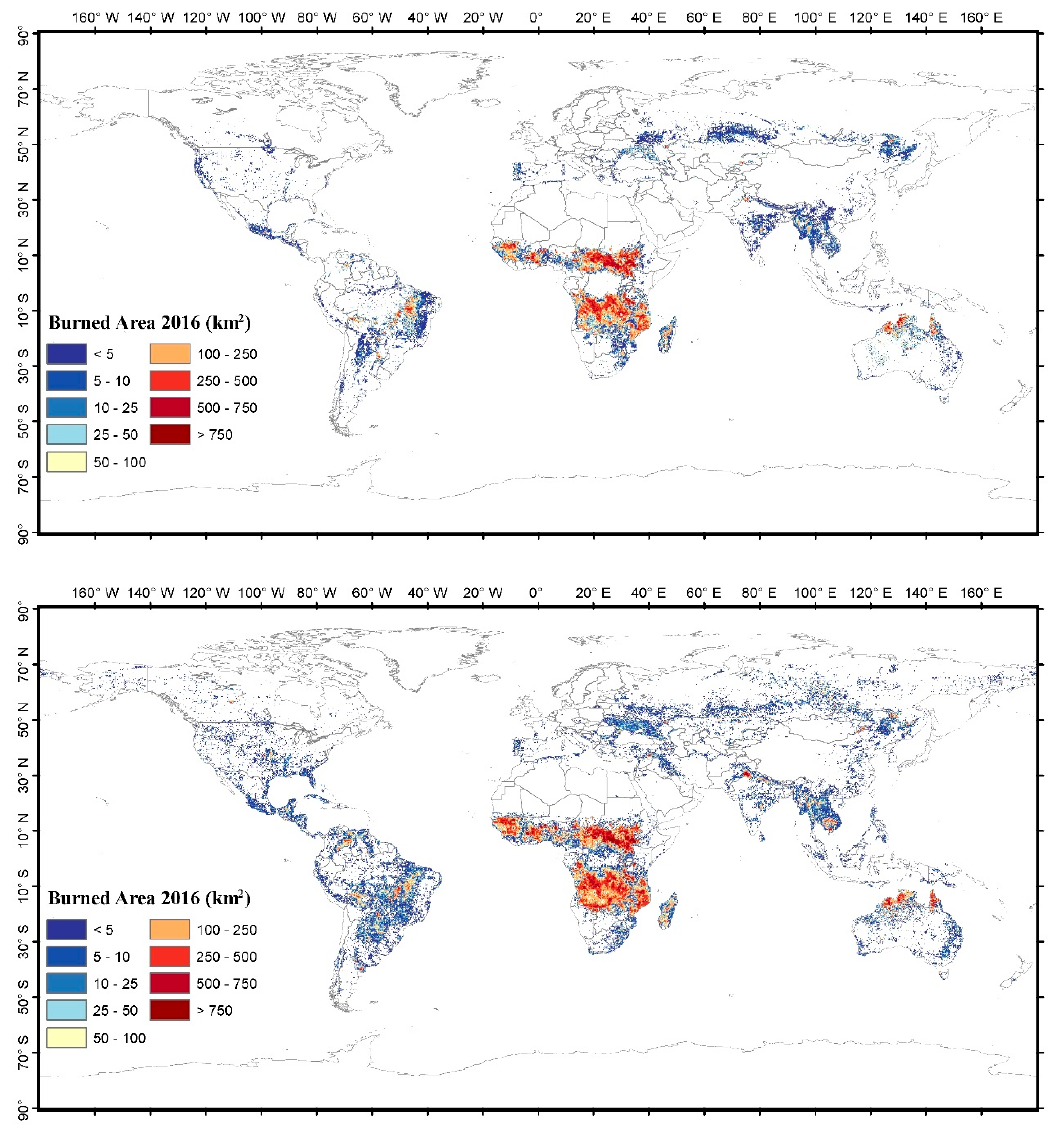
Figure 12. FireCCILT10 ( top ) and MCD64A1 ( bottom ) burned area in 2016.